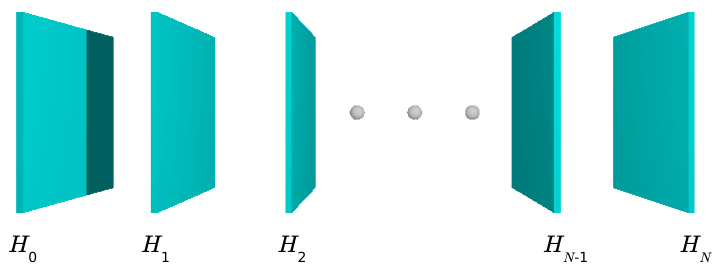
Figure 10. Schematic of a transfer matrix method (TMM) calculation. Assuming the system has a width and height equal to M for each slice of a N -slice cuboid, forming a “bar” of length N , the amplitude of the wavefunction in the 0-th slice can be related to that in the N-th slice via the transfer matrix, Equation